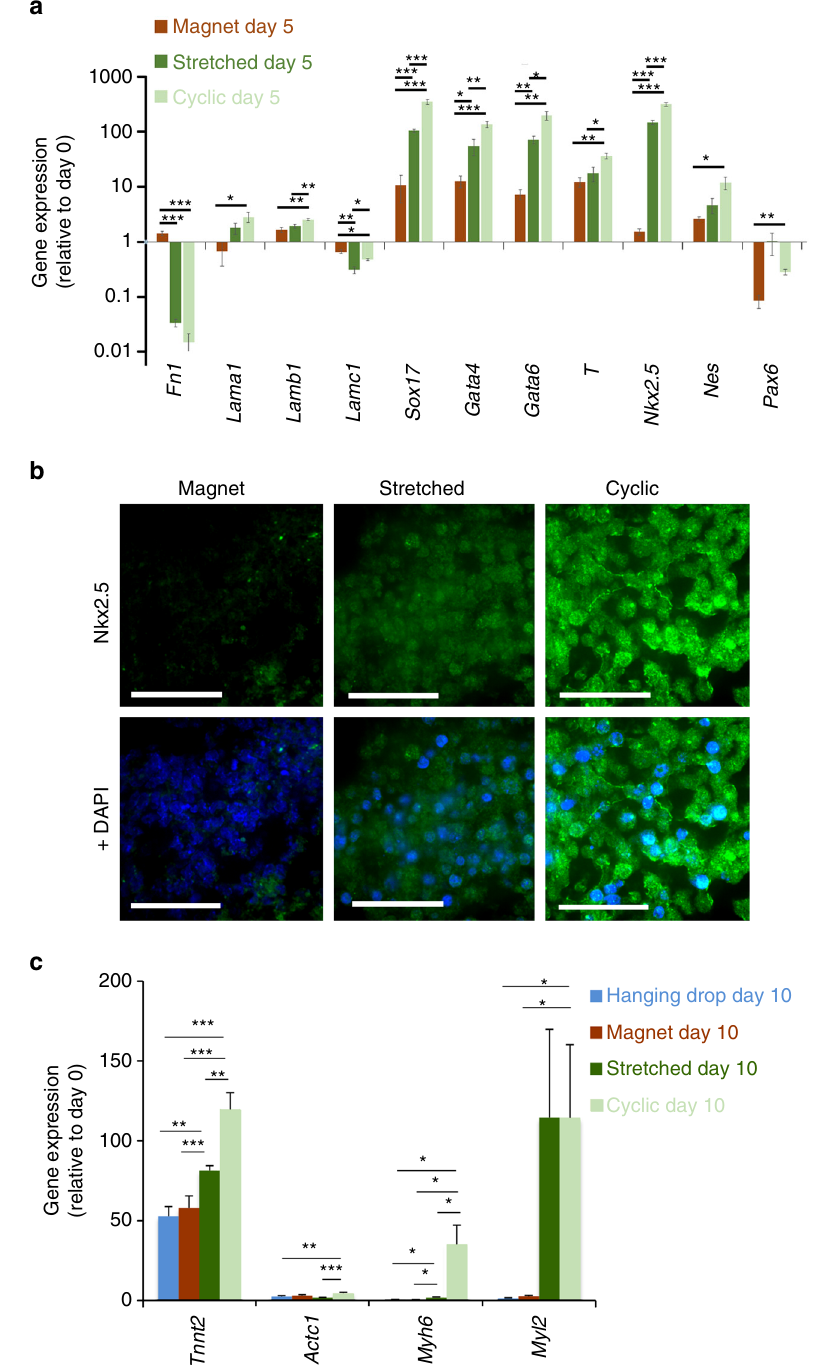
Fig. 6 EBs characterization for the magnet, stretched and cyclic conditions. a Expression of genes characteristic of the different embryonic cell layers in EB after 5 days maturation (day 5). All EBs were obtained from 10,000 magnetized ESCs. Magnet: EB created on a magnetic microtip; Stretching: EB formed on a magnetic microtip, then stretched between two microtips; Cyclic: as before, plus stimulation at 1 Hz twice a day for 3 days. Gene expression (normalized to RPLP0 ) is calculated relative to the same gene expression at day 0 before EB formation. b Immunostaining (in green) of Nkx2.5 for EBs in the three conditions, with DAPI staining overlaid on the right. Images are obtained at the center of each EB. Scale bar : 50 µ m. c Gene expression at longer maturation times (day 10) for speci fi c cardiac markers cardiac troponin T ( Tnnt2 ), cardiac α -actin ( Actc1 ), α myosin heavy chain ( Myh6 ) and myosin regulatory light chain 2 ( Myl2 ). All EBs were obtained from 10,000 ESCs. For the hanging drop formation (blue), ESCs were not labeled with the magnetic nanoparticles. For the three other conditions, ESCs were magnetic (3 pg of iron per cell): EB formation by magnet with no further stimulation (dark red), stretched stimulation (dark green) and cyclic stimulation (light green). mRNA levels are shown relative to control (day 0, de fi ned as 1), and normalized to reference gene RPLP0. Error bars represent the